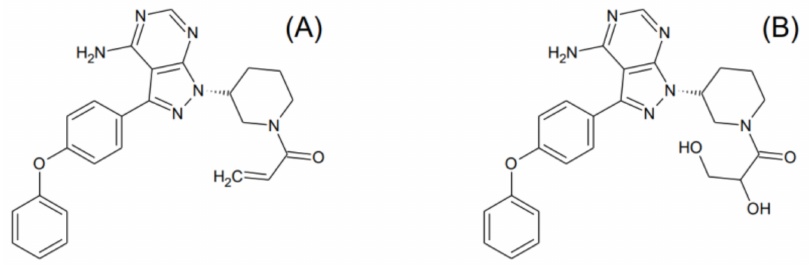
Figure 1. Structural formulae of ( A ) ibrutinib and ( B ) dihydrodiol ibrutinib. Treatment with IBR requires careful guidance in dosing, primarily due to its severe adverse effects caused by off-target kinase inhibition and other mechanisms [4]. These include atrial fibrillation, the most common reason for the discontinuation of IBR therapy, major bleeding (occurring in 1–10% of patients), general debility, arthralgia, infection (especially pneumonitis), and secondary malignancy. Fatalities associated with these have been reported in up to 10%, while dose modification is prompted in 11–50% of cases [5]. A multicenter, retrospective chart study including adults treated with chronic lymphocytic leukemia revealed that—mainly due to the occurrence of adverse events—25% of patients experienced at least one dose reduction, while treatment discontinuation and dose holds impacted 20% and 34% of cases, respectively